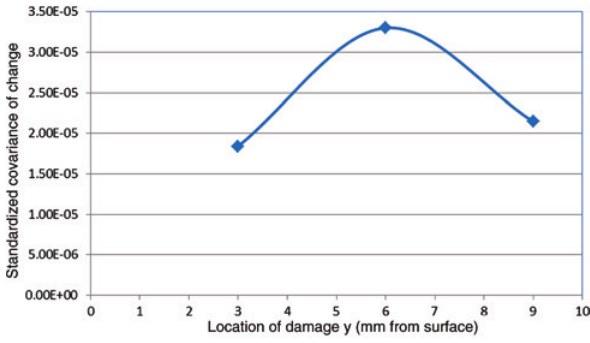
Figure 28: Covariance of energy change for full section with varying damage depth.